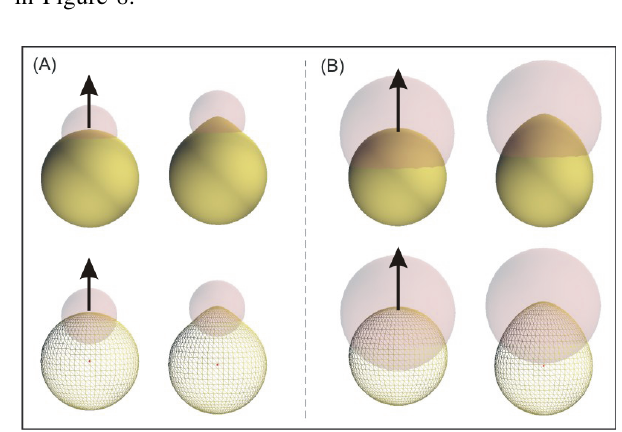
Figure 6. Influence zones application by translation.